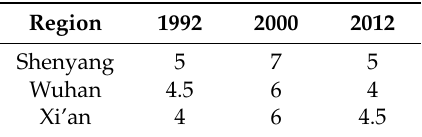
Table 1. Multitemporal suburban gray limits.